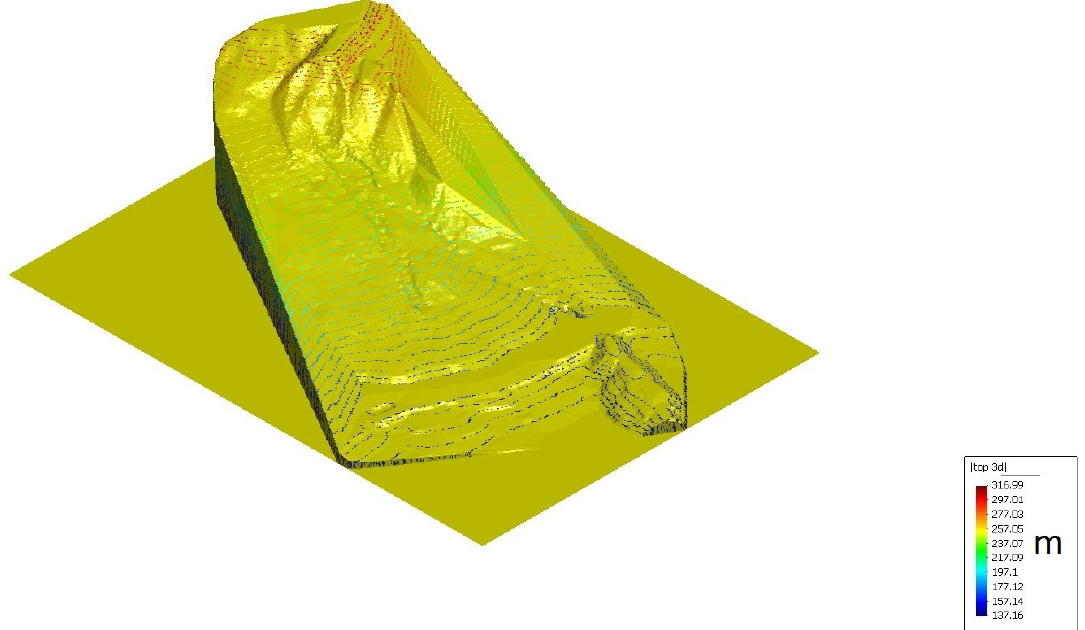
Figure 7. The Aberfan 3D topographic mesh generated using the map of Figure 6 as a starting point. Different colors represent different isolines’ height.